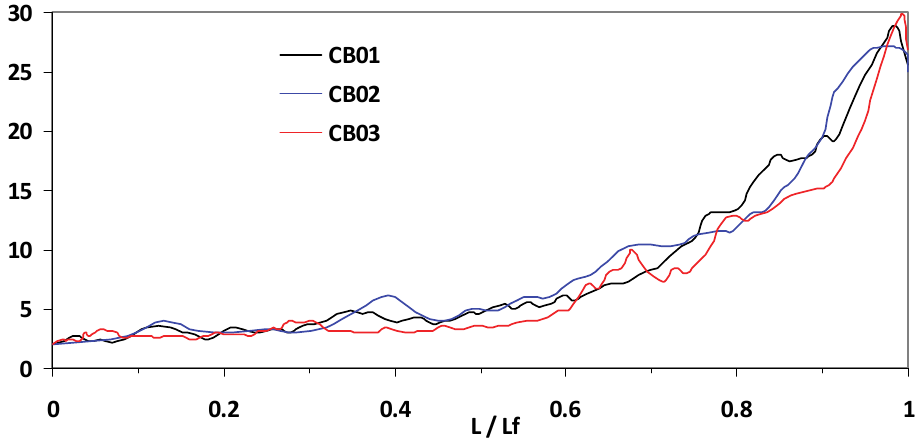
Figure 3: PSC versus normalized load (L/L f ) for all three experiments